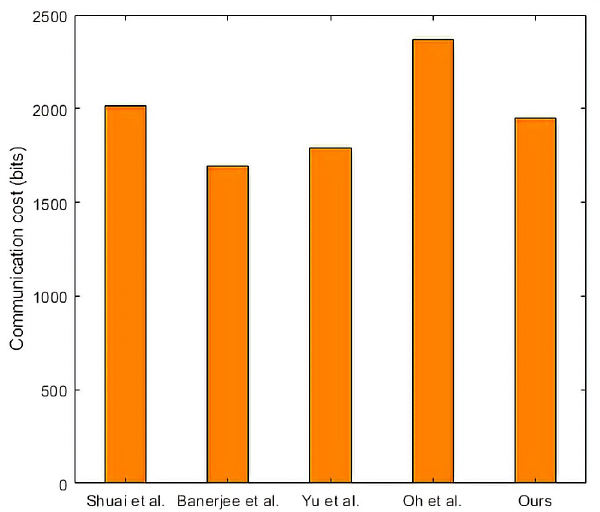
Figure 10. Comparisons of communication cost. Shuai et al. [37], Banerjee et al. [40], Yu et al. [18], and Oh et al.